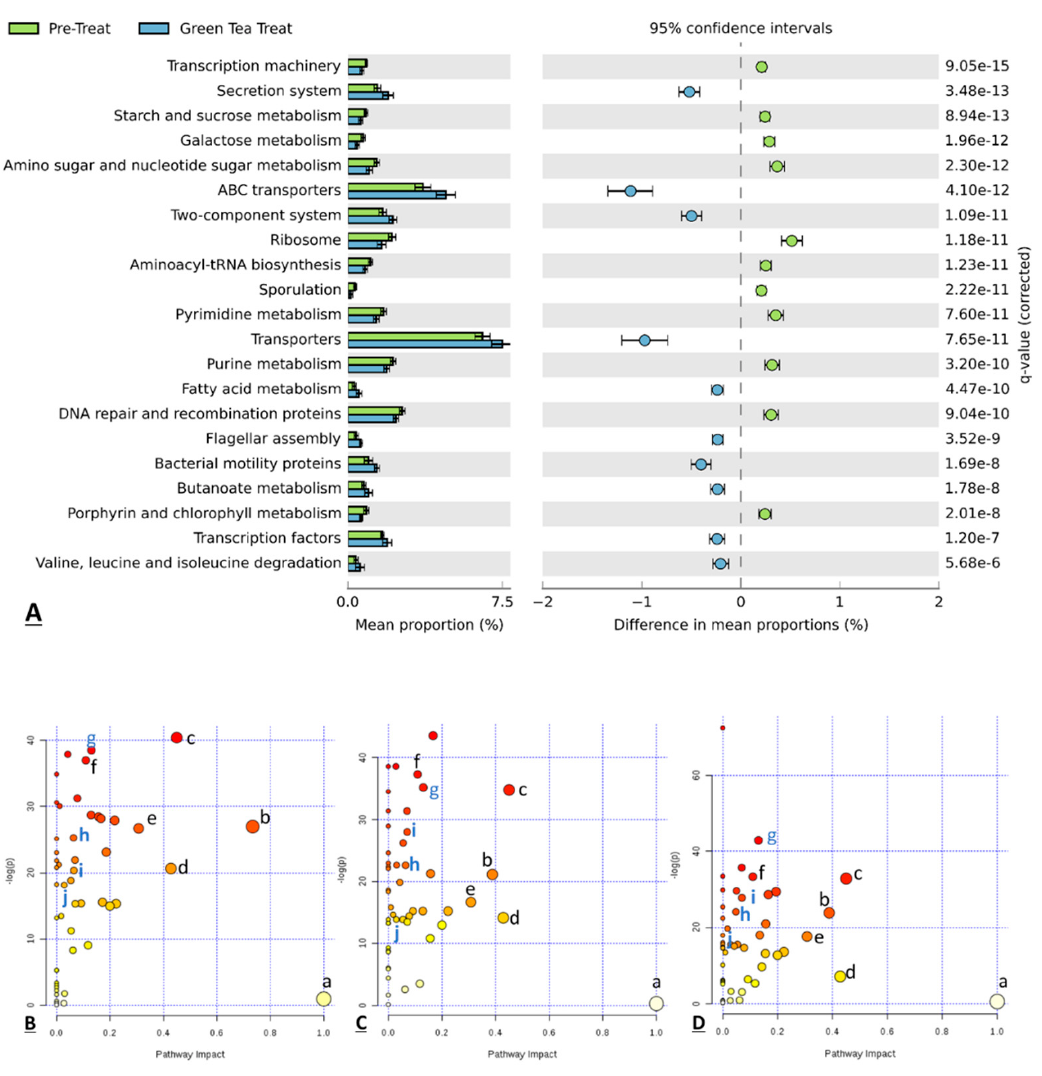
Figure 7. The difference in the mean proportion of microbial functions between the pretreatment samples and treated samples along with the associated 95% confidence interval of this effect size, q -value below 0.005, and the difference between proportions above 0.2 ( A ). Representative pathway analysis indicated major pathways in the comparison of pretreatment samples vs. green tea treated samples (( B – D ) for vessel 1, vessel 2, and vessel 3). Some common pathways of three vessels that have –log( p ) above 10 are labeled in lower case letters as: a. Inositol phosphate metabolism; b. Alanine, aspartate, and glutamate metabolism; c. Glycine, serine, and threonine metabolism; d . Biotin metabolism; e . beta-Alanine metabolism; f. Cysteine and methionine metabolism; g. Aminoacyl-tRNA biosynthesis; h. Pyrimidine metabolism; i. Purine metabolism; j. Butanoate metabolism.